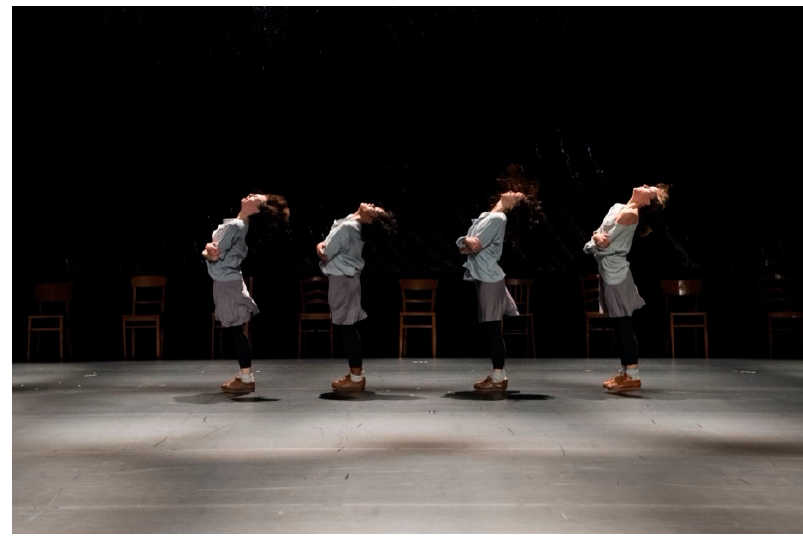
Figure 2. Rosas danst Rosas (2017) Anne Teresa De Keersmaeker/Rosas @ Anne van Aerschot. Used with permission.